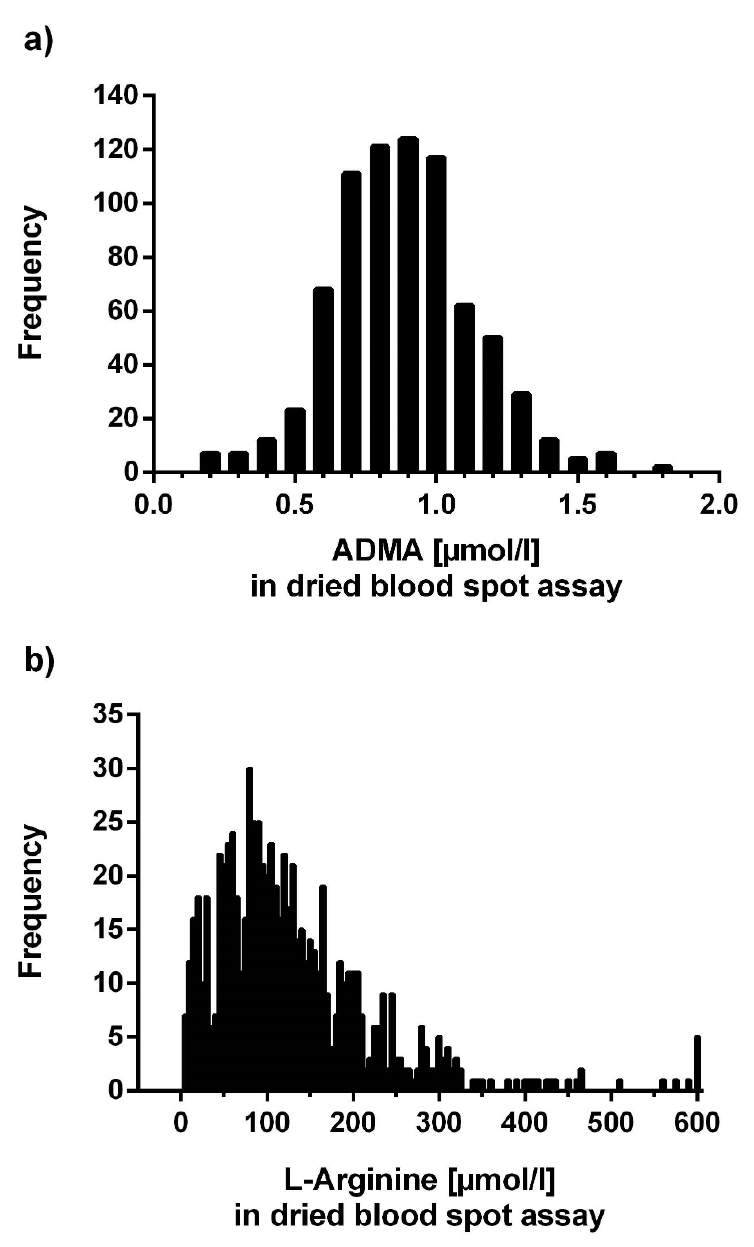
Figure 8. Distribution of ADMA concentrations ( a ) and L-arginine concentrations ( b ) in dried blood spots.